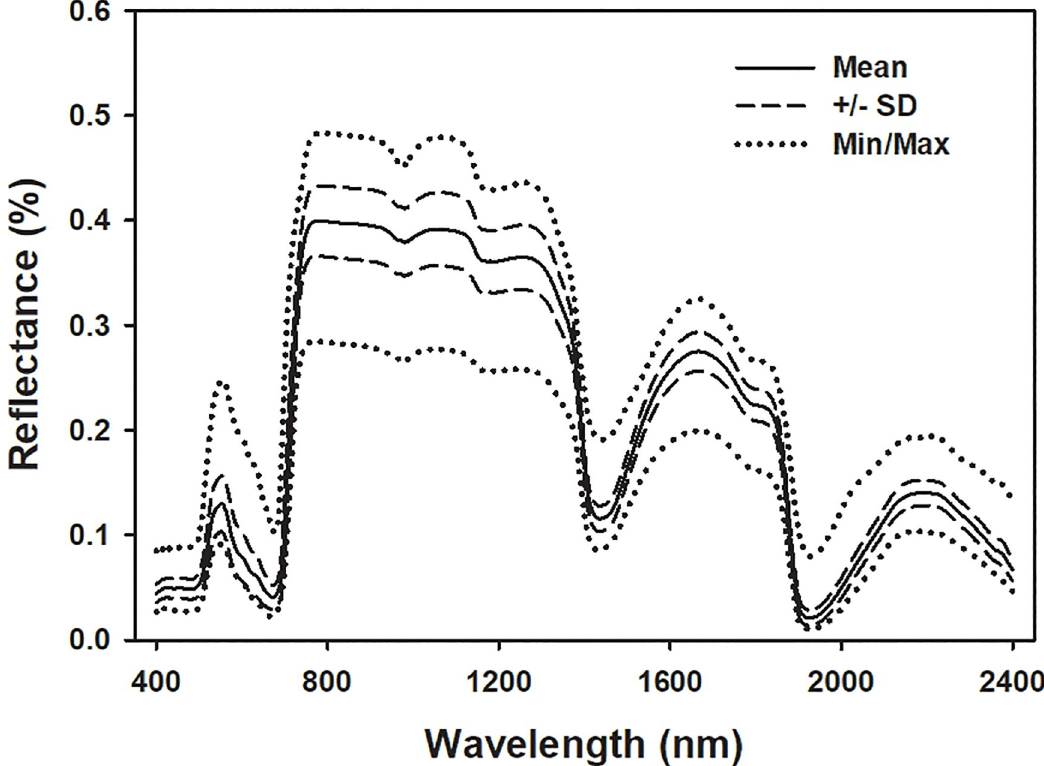
Fig 1. Mean, ± standard deviation (SD), minimum (Min), and maximum (Max) wheat reflectance values.